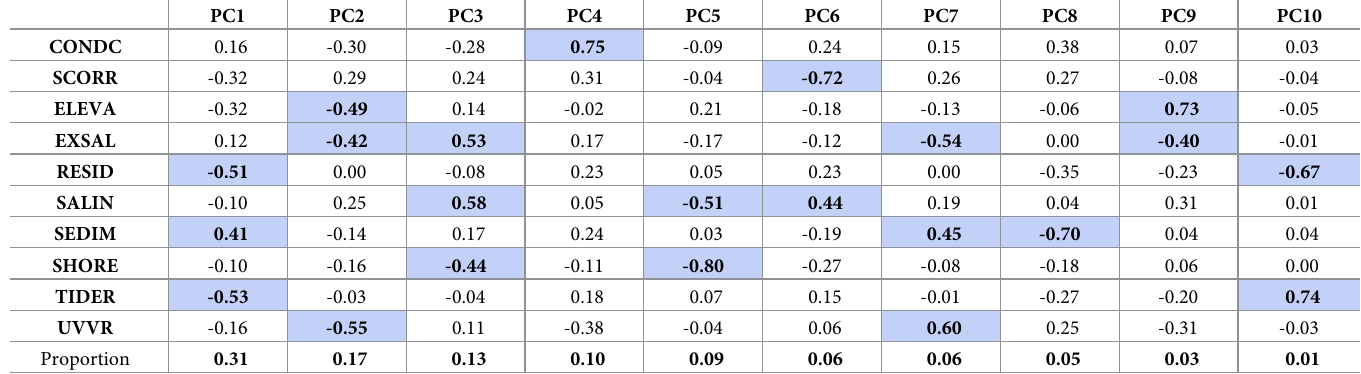
Table 3. Principal components analysis. Principle component loadings (PC1–PC10) for each vulnerability indicator. Blue indicates loadings with a magnitude greater than 0.4.